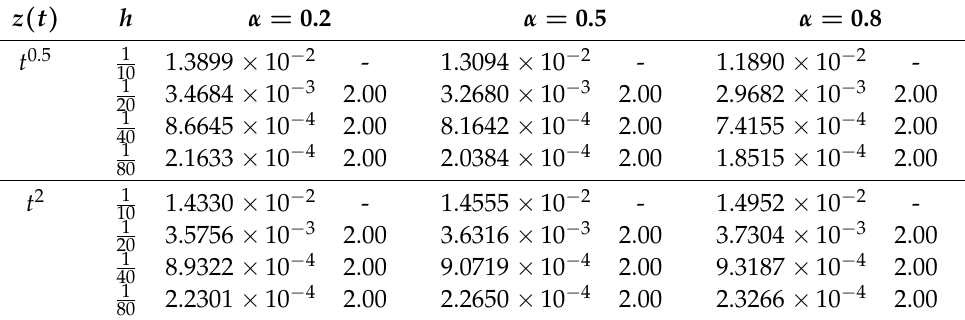
Table 6. (Example 2) Spatial convergence order for various α when N =